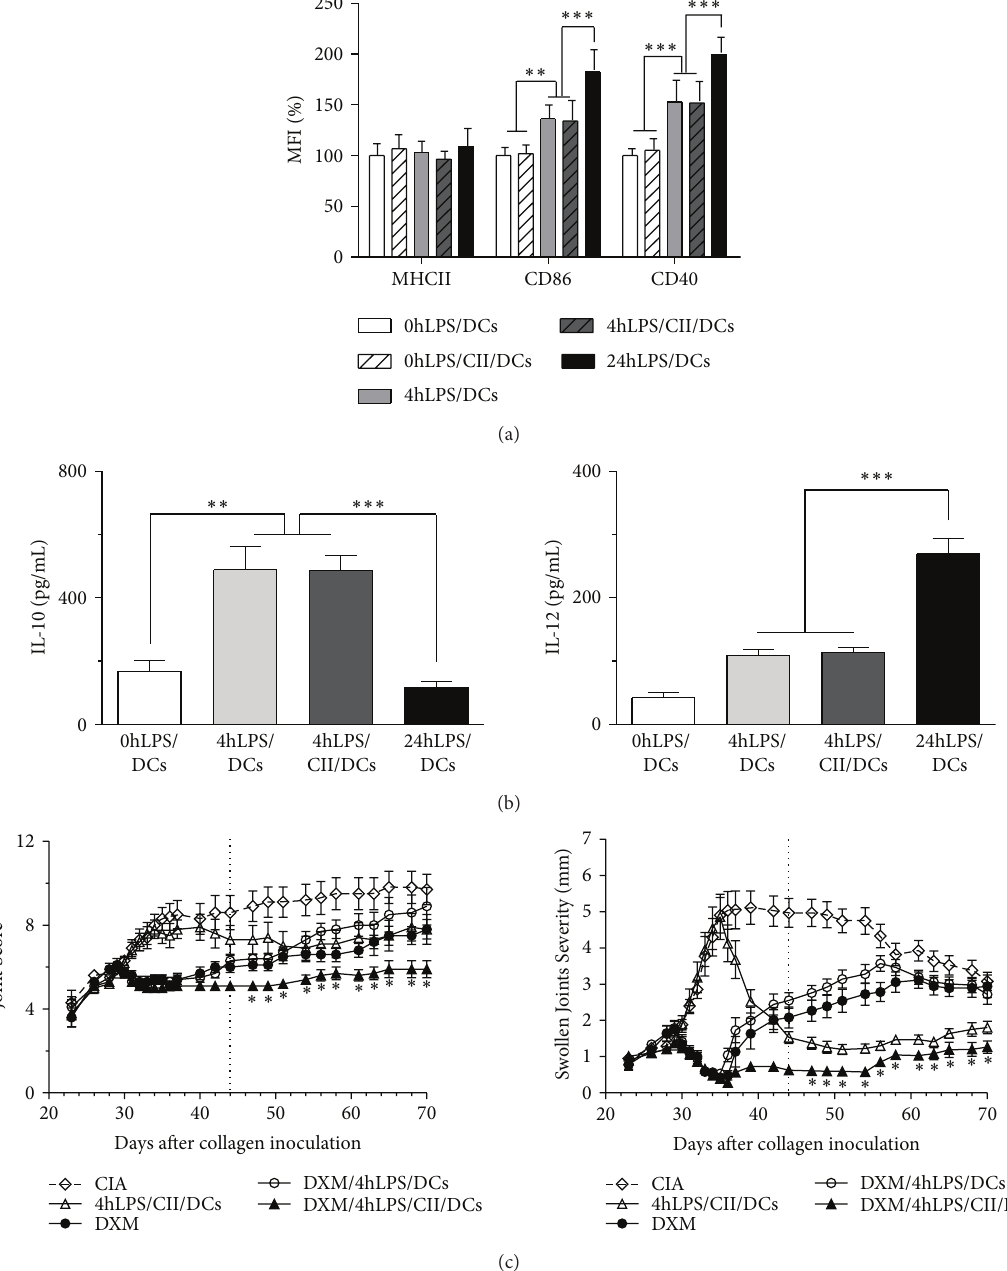
Figure 2: Dexamethasone (DXM) preconditioning improves the effect of 4-hour lipopolysaccharide-(LPS-) stimulated dendritic cells (DCs) in modulating active CIA. (a) Isolated CD11c+ DCs were stimulated with LPS for 4 hours (4hLPS/CII/DCs) and loaded for 24 hours with bovinetypeIIcollagen(CII)orleftunloaded(4hLPS/DCs).LPS-untreatedDCsloadedwithCII(0hLPS/CII/DCs)orunloaded(0hLPS/DCs), or treated for 24 hours with LPS (24hLPS/DCs) were used as controls. The expression of major histocompatibility complex (MHC) class II and costimulatory molecules (CD86 and CD40) was analyzed by flow cytometry. Values are expressed as percentage of increase in mean fluorescence intensity (MFI) related to 0hLPS/DCs. Data from a representative experiment of three experiments performed are shown. ∗∗ 𝑃 < 0.01 and ∗∗∗ 𝑃 < 0.001 . (b) Cytokine production by differentially stimulated DCs was assessed by ELISA. Bars represent the mean of three experiments performed in duplicate. ∗∗ 𝑃 < 0.01 and ∗∗∗ 𝑃 < 0.001 . (c) Mice with active CIA received 2.0mg/kg DXM from days 29 to day 34 after CIA induction (DXM group). Then, mice were inoculated intraperitoneally at day 35 with 5 × 10 5 DCs as follows: 4-hour LPS- stimulated DCs (DXM/4hLPS/DCs) and 4-hour LPS-stimulated DCs loaded with CII (DXM/4hLPS/CII/DCs). The 4hLPS/CII/DCs group received 4-hour LPS-stimulated DCs loaded with CII, but without DXM preconditioning. The CIA control group corresponds to mice that did not receive any treatment. The two-tailed ANOVA test and Bonferroni’s post-test were applied when comparing Joint Score and Swollen Joints Severity Score curves from day 44 to day 70. Data from a representative experiment of three experiments performed with 8–10 mice per group are shown. ∗ 𝑃 < 0.001 in DXM/4hLPS/CII/DCs versus CIA